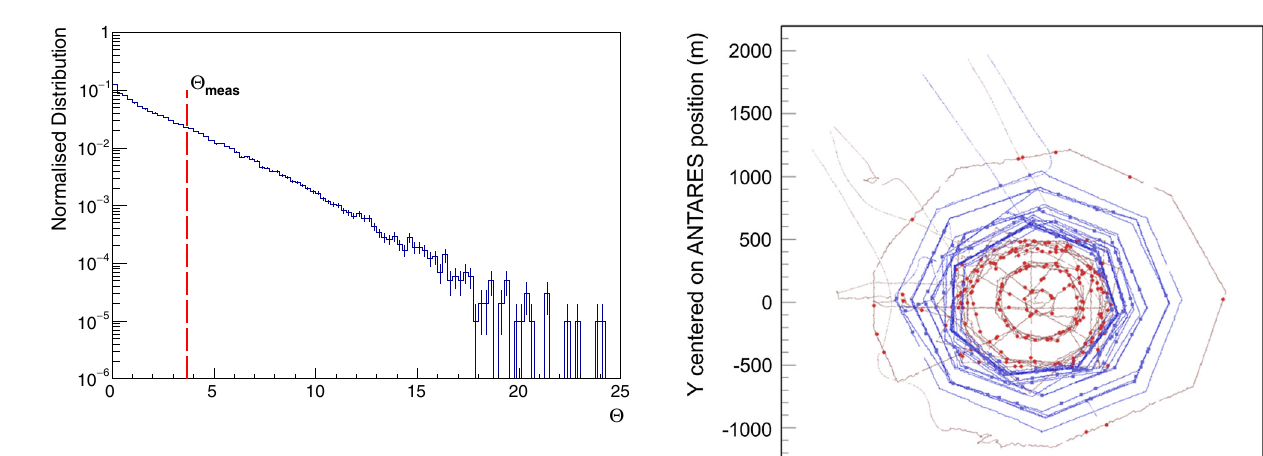
Fig. 7 Distribution of the Θ = λ O − λ min test statistics, obtained with 10 5 pseudo-experiments assuming the Moon in the nominal position O . The 23% of the pseudo-experiments has a test statistic Θ larger than the measured value Θ meas = 3 . 68, indicated for reference by the red-dashed line